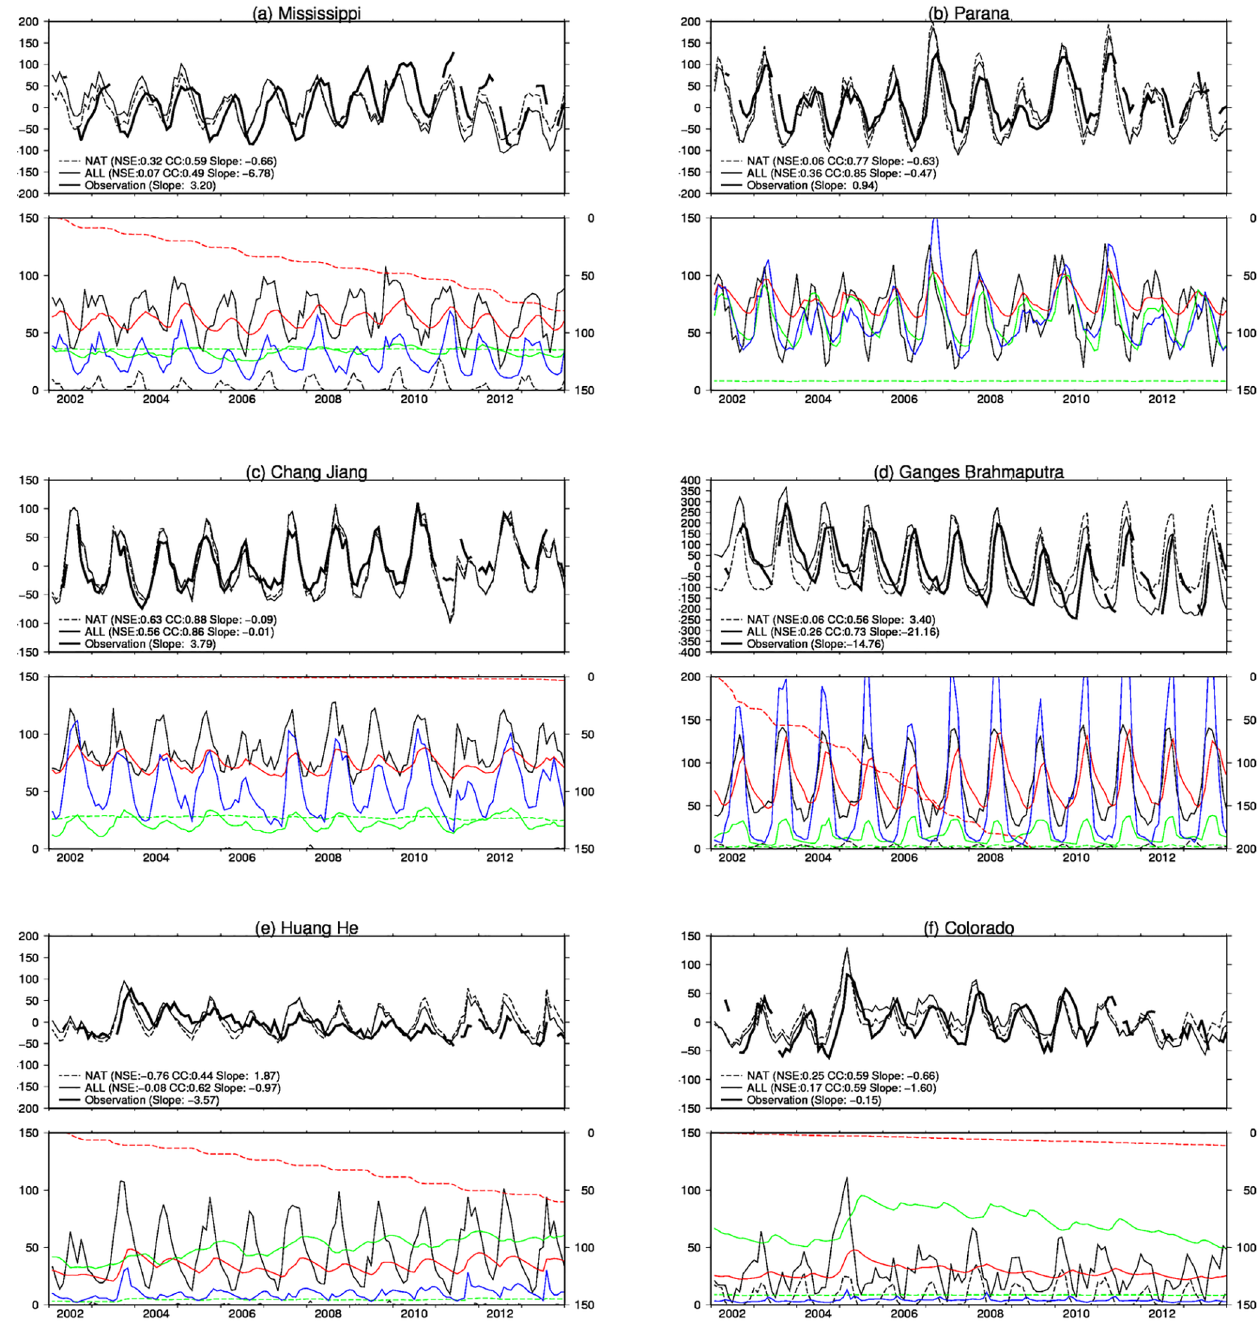
Figure 10. Terrestrial water storage (TWS) variations in the (a) Mississippi, (b) Parana, (c) Chang Jiang, (d) Ganges, (e) Huang He, and (f) Colorado river basins. The top panel of each figure shows the terrestrial water storage anomaly (TWSA) (mm). The bottom panel of each figure shows the simulated TWS component (mm): solid black (soil moisture), broken black (snow water), solid red (renewable groundwater), broken red (storage change in nonrenewable groundwater reservoir, i.e., cumulative volume of nonrenewable groundwater abstraction, right axis), solid green (storage in global reservoirs), broken green (storage in local reservoirs), and solid blue (river water). Note the sign of the cumulative volume of nonrenewable groundwater abstraction, where a positive sign denotes a decrease in water